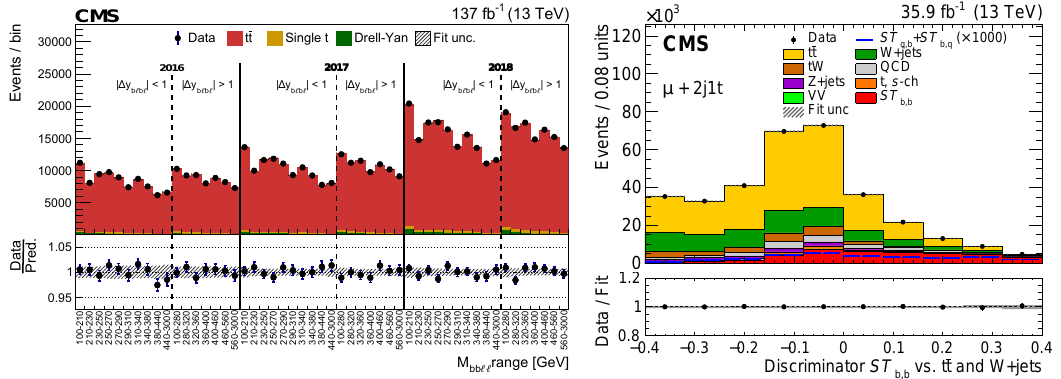
Figure 2: Comparison between measured data and SM expectation in different bins of mass and rapidity bins for a post-fit result of Y the multivariate discriminator comparing data to simulation after the fit procedure (right) [ 11 ]